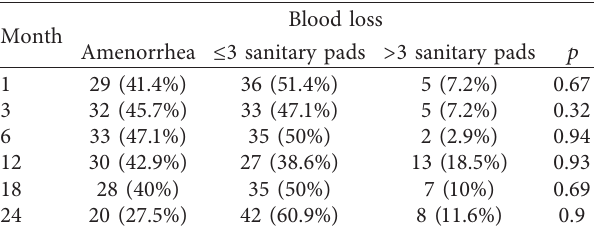
Table 5: Characteristics of blood loss in two-rod